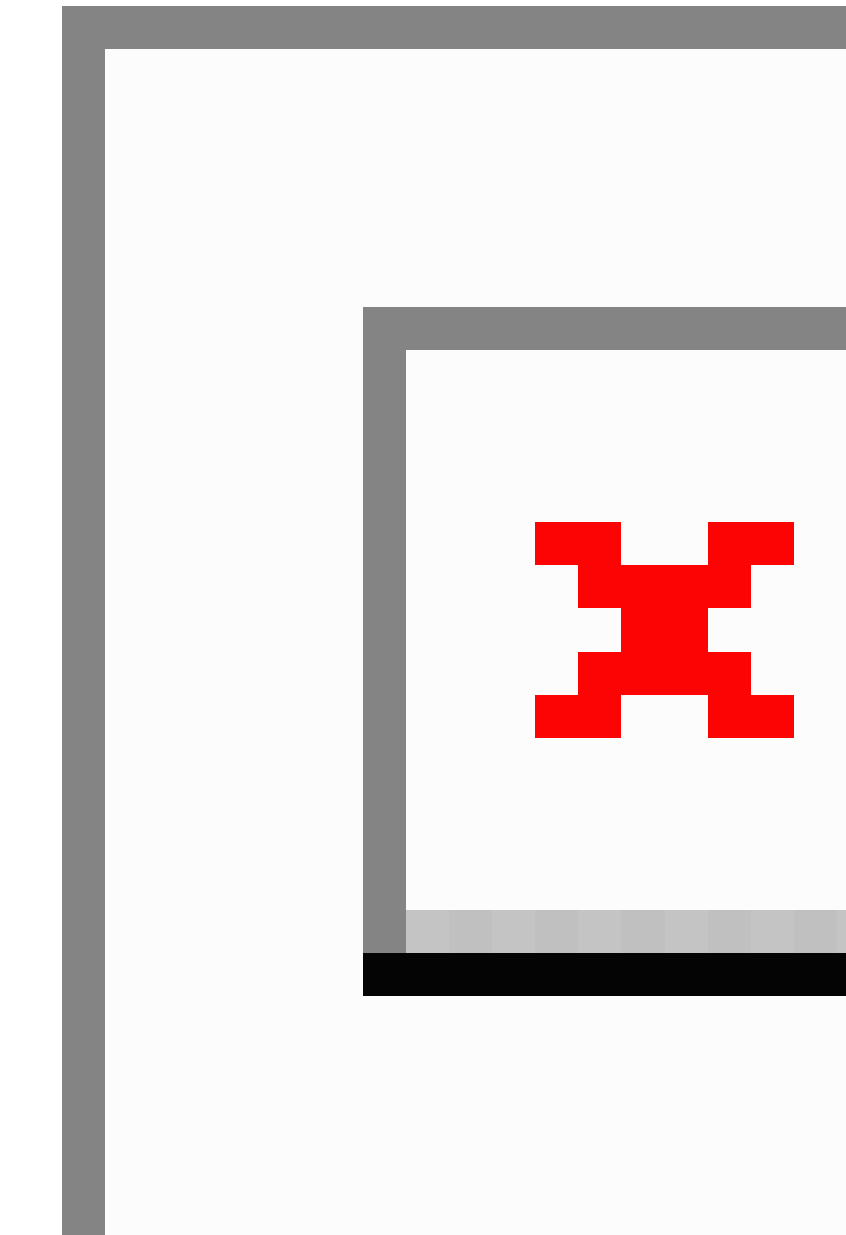
Figure 1. Screenshots of Monster Manor. Children can input their blood glucose measurements using an on-screen numeric pad and earn virtual coins to buy various in-game items that are essential for progression through the